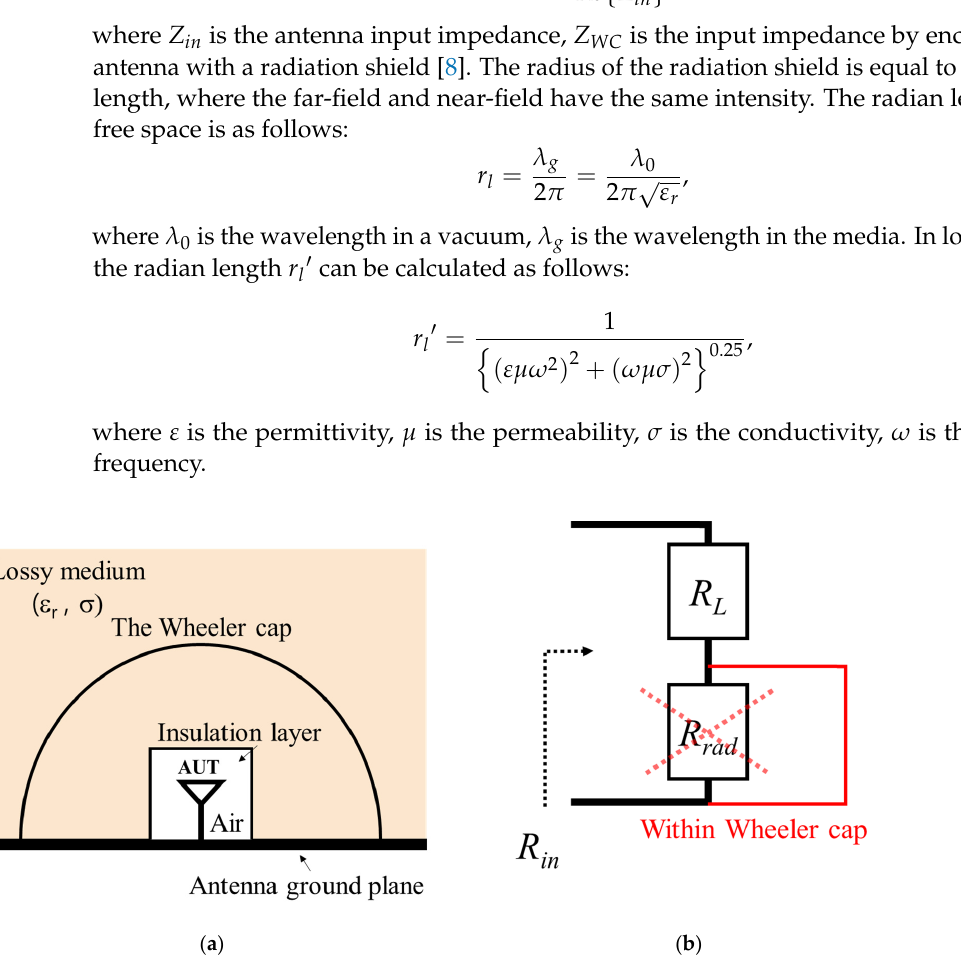
Figure 2. Simulation setup for calculation of radiated power.